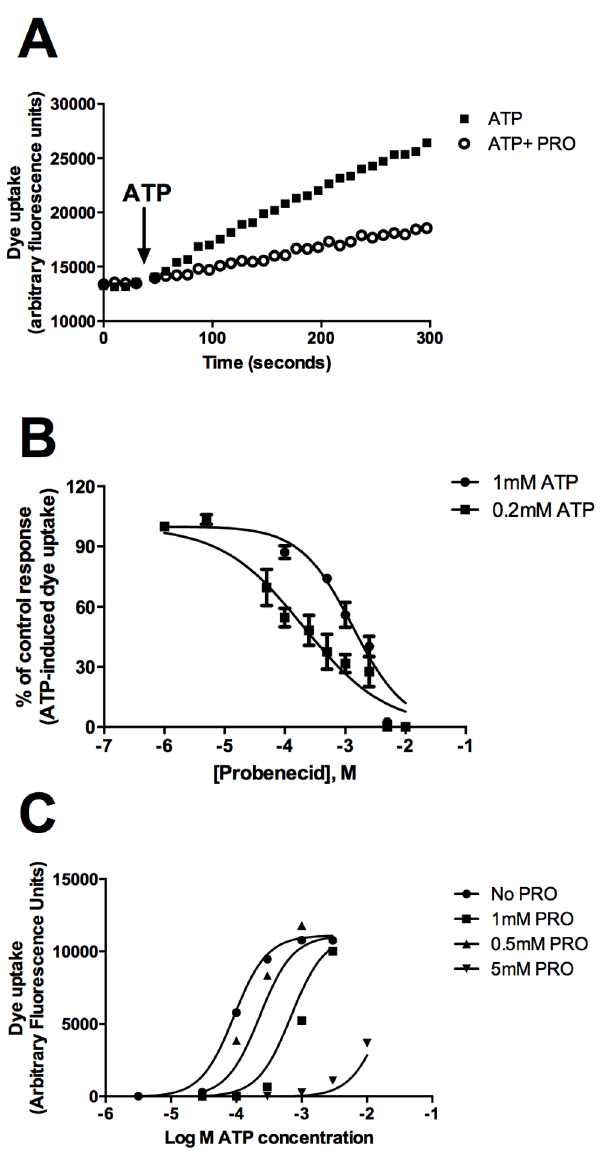
Figure 2. Probenecid inhibits ATP-induced dye uptake in HEK- hP2X7 cells. (A) Ethidium + uptake was induced in HEK-hP2X7 expressing cells by the addition of 1 mM ATP (as denoted by the arrow) in low divalent physiological solution. Control ethidium uptake to ATP is shown in black squares and ethidium uptake in the presence of 2.5 mM probenecid (pre-incubated for 10 minutes at 37 u C) is shown in open circles. (B) Concentration response curves for probenecid on human P2X7 dye uptake responses induced by 0.2 mM or 1 mM ATP. Data was calculated at 300 second timepoint as baseline corrected endpoint data and normalised to the ATP control. Data was fit using a normalised response variable slope in GraphPad Prism. (C) Concentra- tion response curves for agonist ATP in the presence of increasing concentrations of probenecid (0.5 mM, 1 mM and 5 mM) showing a rightward shift.